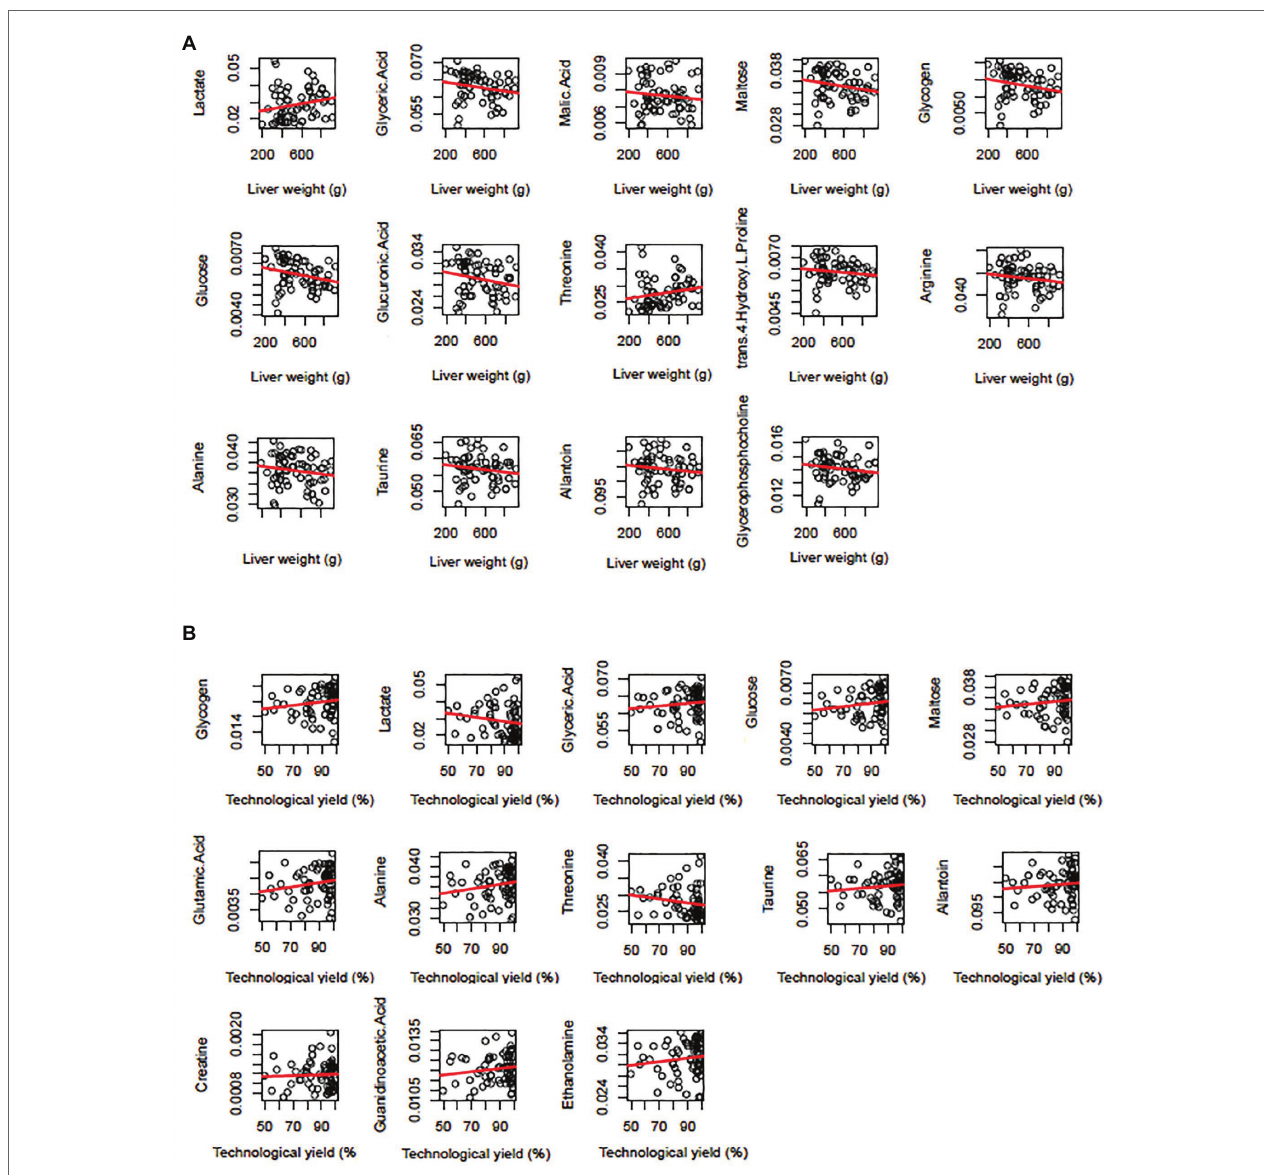
FIGURE 6 | Plots of biomarker relative contents in function of liver weight (A) or liver technological yield (B) . The metabolite relative contents were computed with the bucket data and had no unit. The regression curves were in red.